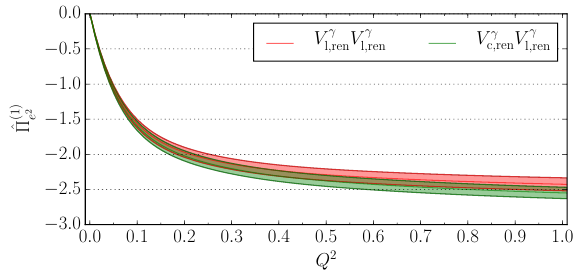
Figure 3. First-order electromagnetic correction to the renor- malised hadronic vacuum polarisation function, at a pion mass of 350MeV [27]. Green and red bands represent di ff erent dis- cretisations of the vector